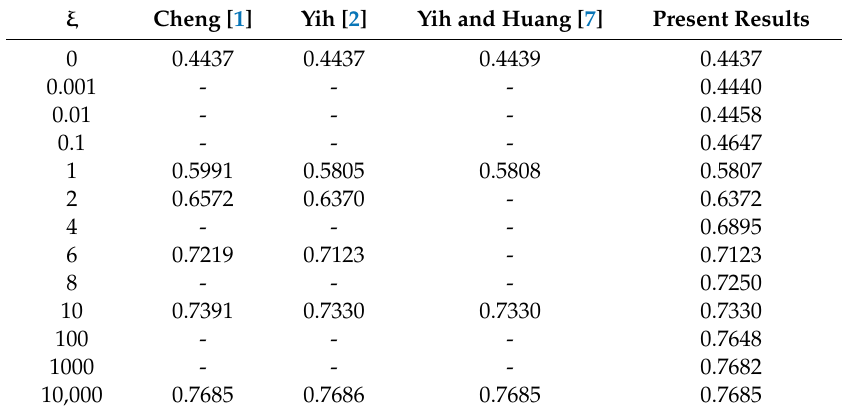
Table 3. Comparison of the values of − θ (cid:48) ( ξ ,0 ) for various values of ξ with N = 0 (pure heat transfer), Le = 1, θ r = ∞ , δ 1 = 0, δ 2 = 0.